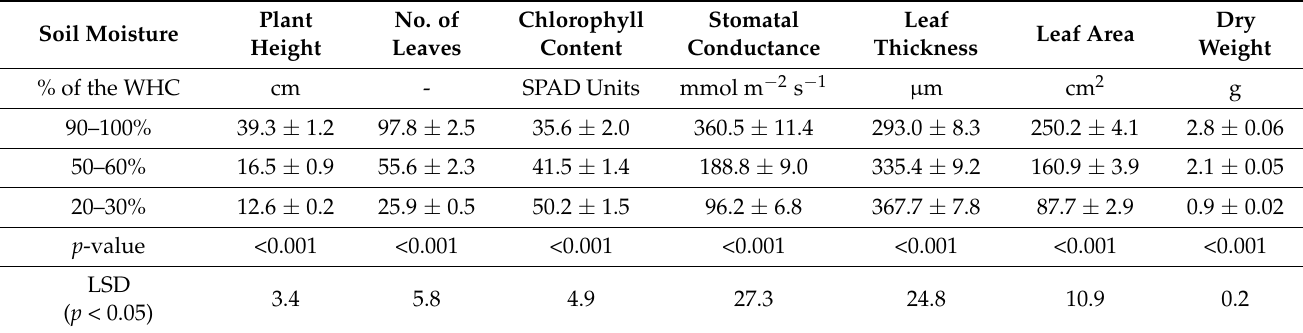
Table 4. Influence of soil moisture regimes on the morpho-physiology and growth of C. bonariensis , measured at 55 to 60 days after emergence. Data collected from repeated experiments with a total of eight replications per